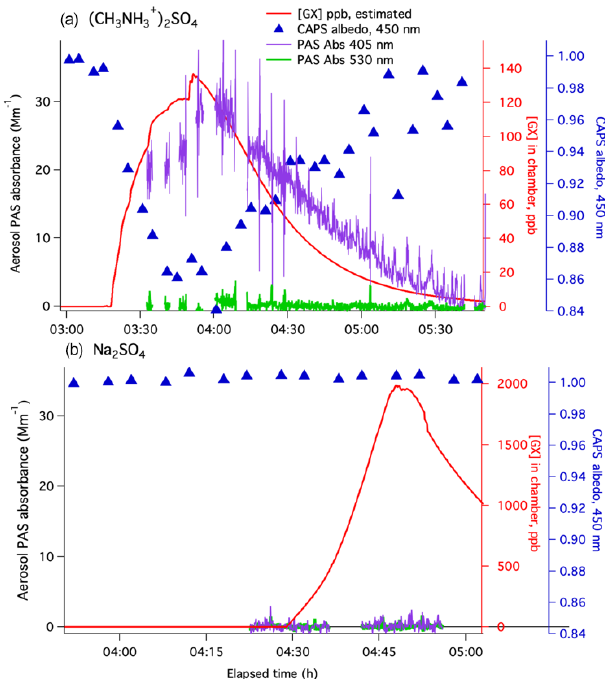
Figure 3. Gradual glyoxal addition experiments in a small Tedlar chamber on (a) dry methylammonium sulfate aerosol (Experiment 5) and (b) dry sodium sulfate aerosol (Experiment 6). Aerosol ab- sorbance measured by PASs at 405nm (purple lines) and 530nm (green lines), aerosol albedo measured by CAPS-ssa at 450nm (blue triangles, blue axis), and estimated glyoxal concentrations in the chamber (red line, red axis; calculated using GX measurements at inlet, flow mixing ratios, and GX wall loss rate = 6 . 7 × 10 − 4 s − 1 ). CRD, SMPS, and 405nm albedo data for these experiments are dis- played in Figs. S3 and